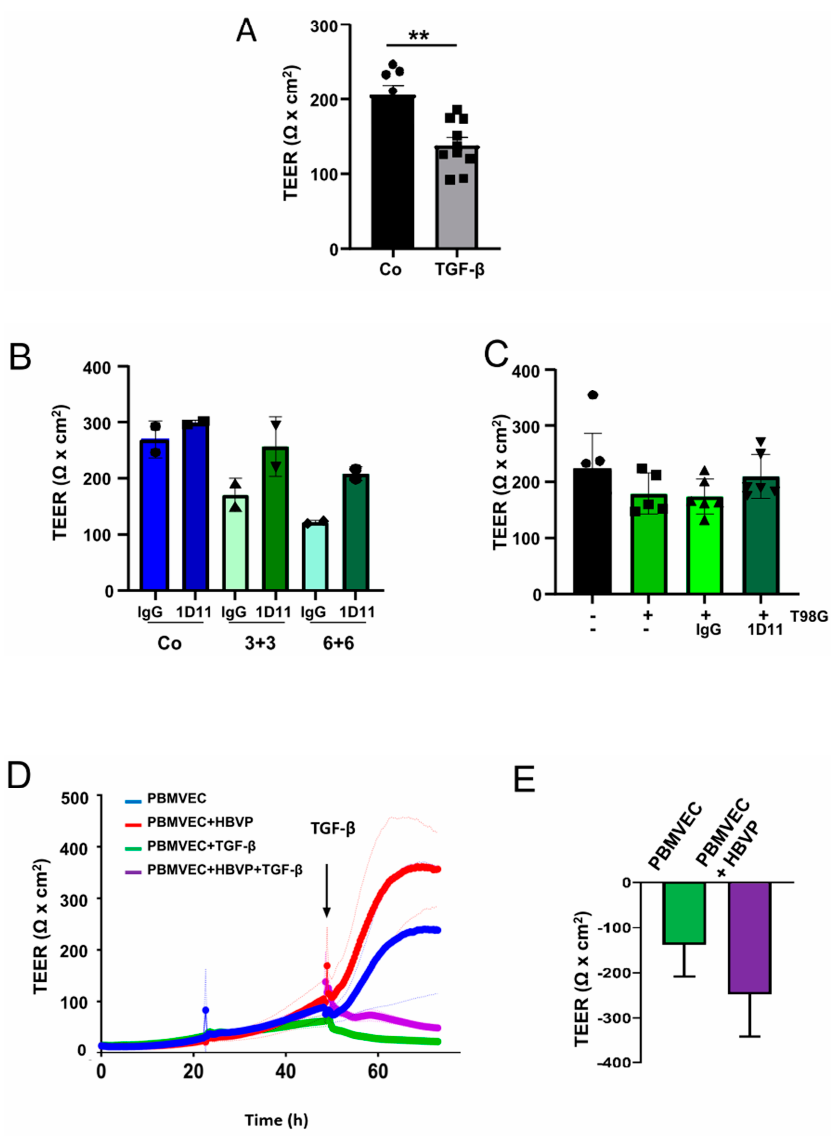
Figure 2. TGF- β negatively modulates the integrity of the BBB in vitro. ( A ) TGF- β negatively modulates the integrity of the barrier. Addition of TGF- β 1 plus - β 2 (each 5 ng/mL; grey bar) into the bottom chamber (HBVP cell membrane side) of barrier-tight BBB layers. Twenty-four hours later, the integrity of the barrier was determined by TEER (Co: sham treatment; black bar). n = 4, each 2 technical replicates, SEM, t -test, ** p < 0.01). ( B ) The cells were treated with TGF- β 1 plus - β 2 [each 3 ng/mL (3+3) or 6 ng/mL (6+6)] in the absence or presence of the pan-TGF- β neutralizing antibody 1D11 (1 µ g/mL). Addition of 1D11 reverted the TGF- β mediated reduction in BBB integrity (Co: sham treatment, n = 2, each one replicate, SD). ( C ) Intact barrier-dense BBB layers were transferred into new wells containing either no cells (black bars) or T98G cells (green bars) as well as no antibody (-), 1D11 antibody, or an isotype control (IgG, each 1 µ g/mL). Twenty-four hours later, TEER measurement was performed ( n = 3, each 2 replicates, SEM, t -test). ( A – C ) Circles, triangles and squares at the appropriate bars present the data points of single experiments. ( D ) PBMVEC monoculture and PMBVEC/HBVP co-culture membranes were treated with TGF- β 1 plus - β 2 (each 5 ng/mL) 48 h after seeding. TEER measurement was performed as described in the Methods section (one out of three independent experiments is shown, light-colored lines indicate the SD of technical replicates). ( E ) Differences in the reduction in TEER in PBMVEC mono- and PBMVEC/HBVP co-cultures after addition of TGF- β 1 plus - β 2 (each 5 ng/mL; n = 3, SD, p =